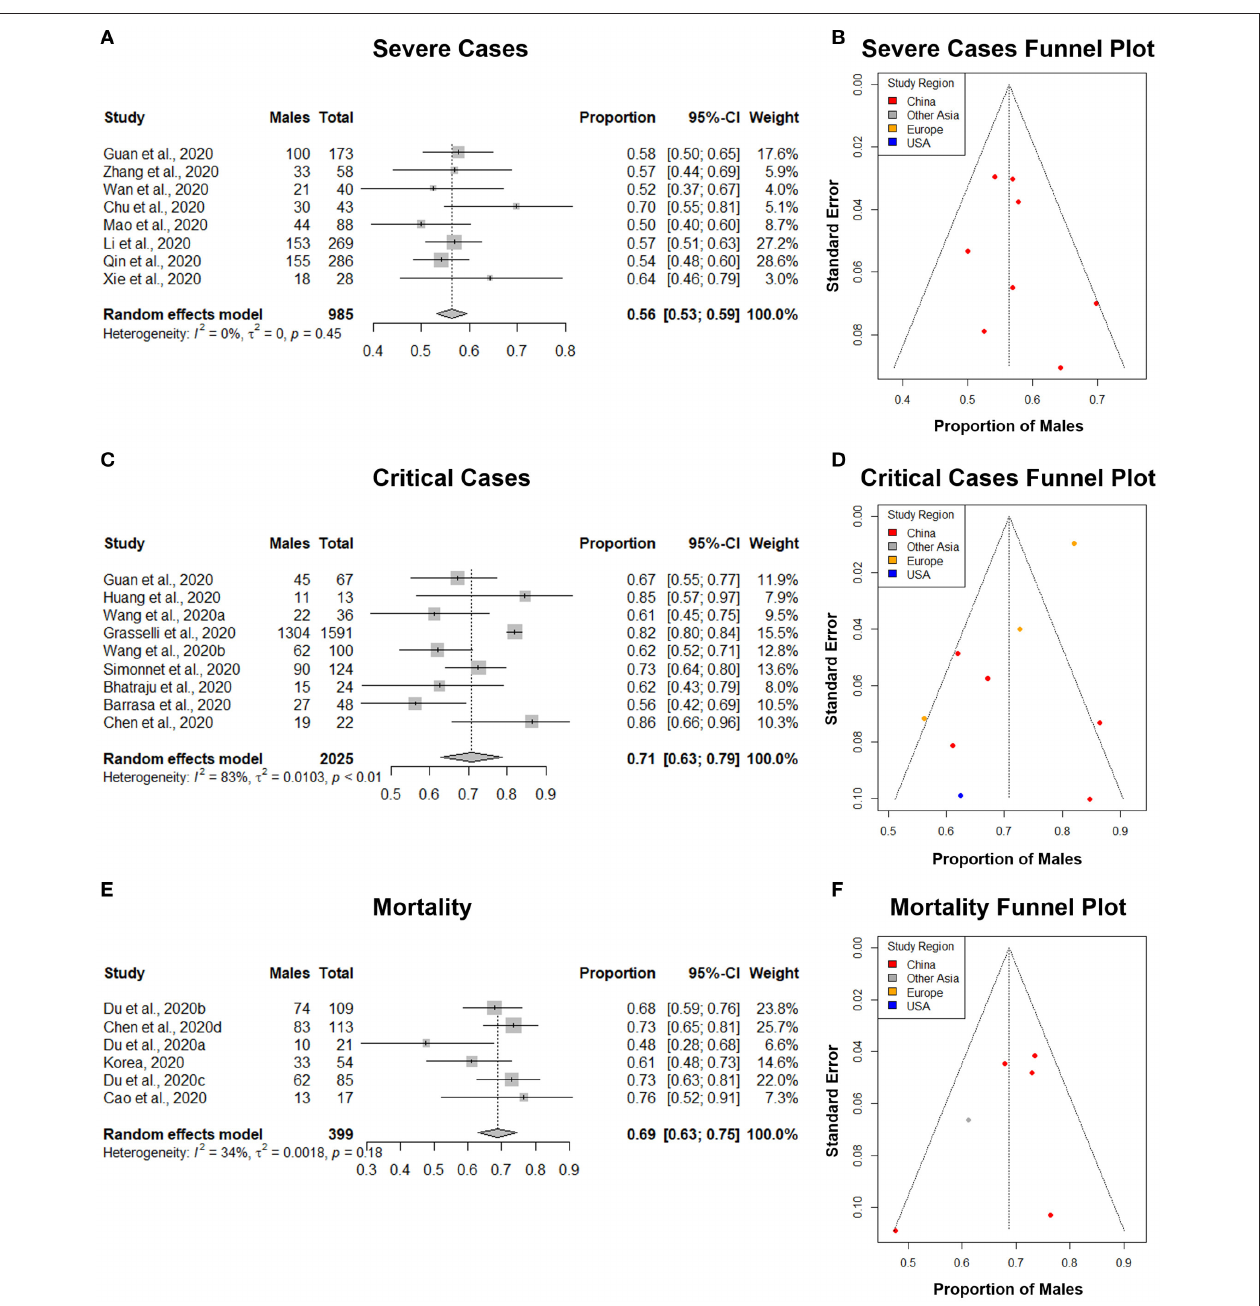
FIGURE 5 | The proportion of males in COVID-19 severe cases, critical cases, and mortalities. (A,C,E) Forest plot of sex-distribution in COVID-19 cases in each of the studies. Proportions of males and the 95% confidence intervals (CIs) are indicated. The vertical dotted lines represent the combined proportion of all studies. The diamond represents the combined 95% CI, the left and right endpoints of which are the lower and upper bounds of the CI, respectively. (A) Severe cases defined as having at least one of the following clinical findings: breathing rate ≥ 30/min, pulse oximeter oxygen saturation (SpO2) ≤ 93% at rest, or ration of the partial pressure of arterial oxygen (PaO 2 ) to the fraction of inspired oxygen (FiO 2 ) ≤ 300 mmHg. (C) Critical case defined as: received mechanical ventilation, clinically diagnosed with shock, received care in the intensive care unit (ICU), or transferred to a tertiary care hospital. (E) Mortality defined as all deaths in COVID-19 patients that occurred during the study period. (B,D,F) Funnel plot with 95% confidence region of sex-distribution in COVID-19 severe cases, critical cases, and mortality in each of the studies.